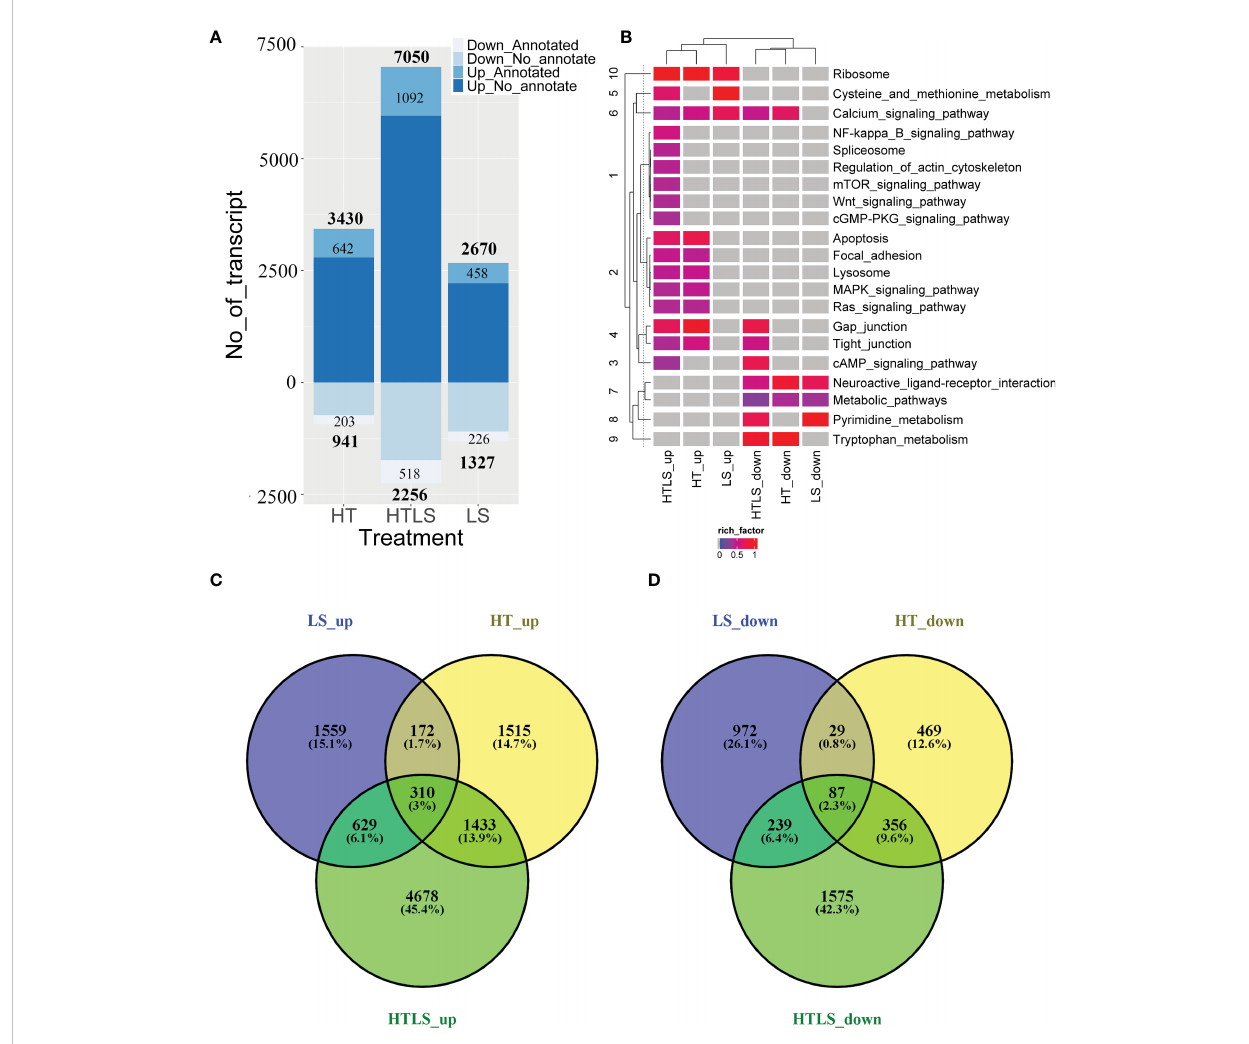
FIGURE 2 A summary of the results of differentially expressed gene (DEG) analysis. Bar chart in (A) summarizes the number of up- and down-regulated differentially expressed genes in each treatment, with labels specifying the number of NCBI nr-annotated and non-annotated transcript. The Venn diagrams in (B, C) compare the list of up- and down-regulated DEGs from each treatment. The heatmap in (D) summarizes the results of functional (KEGG terms) enrichment analysis results for up- and down- regulated DEGs, with the color specifying enrichment q -value of each enriched term, grey denoted no enrichment of the functional KEGG